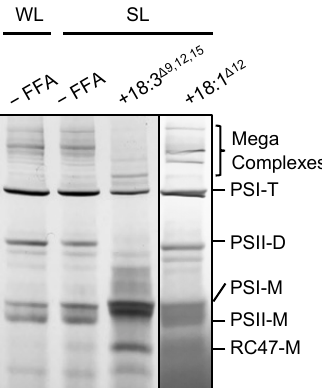
Figure 3. Effect of unsaturated C18 FFAs on photosynthetic complexes. Protein complexes in thylakoid membranes from cells incubated without (–FFA) or with 50 µ mol L − 1 18:3 ∆ 9,12,15 or 18:1 ∆ 12 under weak light at 70 µ mol photons m − 2 s − 1 (WL) or strong light at 1500 µ mol photons m − 2 s − 1 (SL) for 20 min were solubilized by 1% ( w / v ) n-dodecyl- β -D-maltoside and separated by Blue-Native polyacrylamide gel electrophoresis. Bands on the gels were visualized by washing out excess Coomassie Brilliant Blue G-250 with distilled water. Bands for the photosynthetic complexes are identified as described previously [19]. PSI-T, Photosystem I trimer; PSII-D, Photosystem II dimer; PSI-M, Photosystem I monomer; PSII-M, Photosystem II monomer; RC47-M, CP43-less Photosystem II monomer.